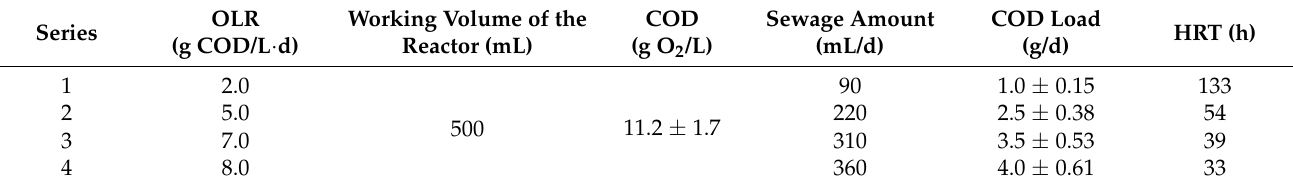
Table 3. Study organization and exploitation parameters in stage